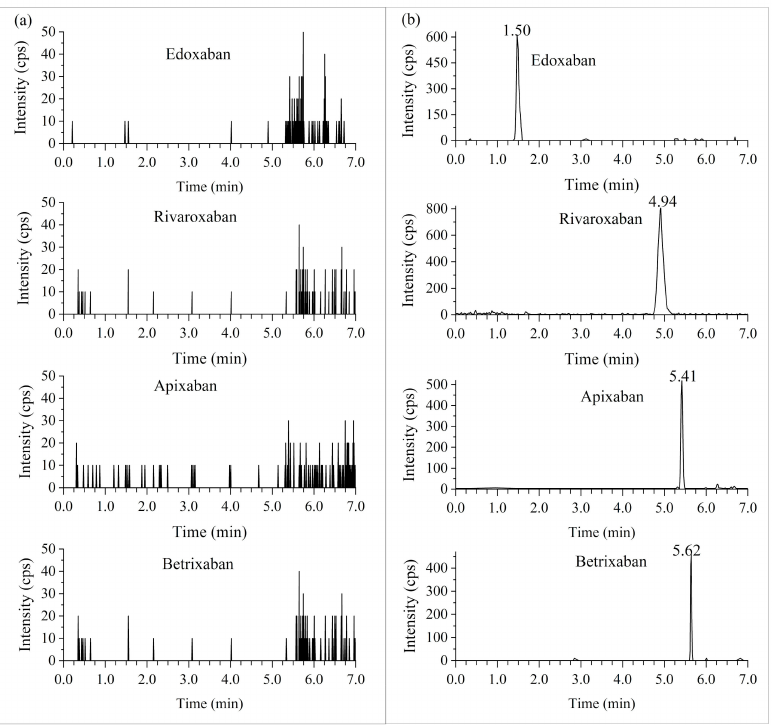
Figure 3. The UPLC/MS/MS chromatograms of processed blank urines ( a ) and spiked with the lower limit of quantitation of 10 ng/mL ( b ) in blank urines of selected DOACs.